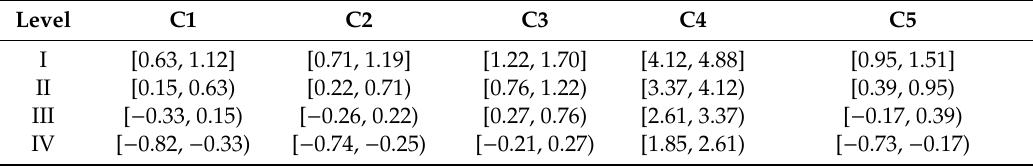
Table 3. The classical domain of agricultural investment climate evaluation index. Level